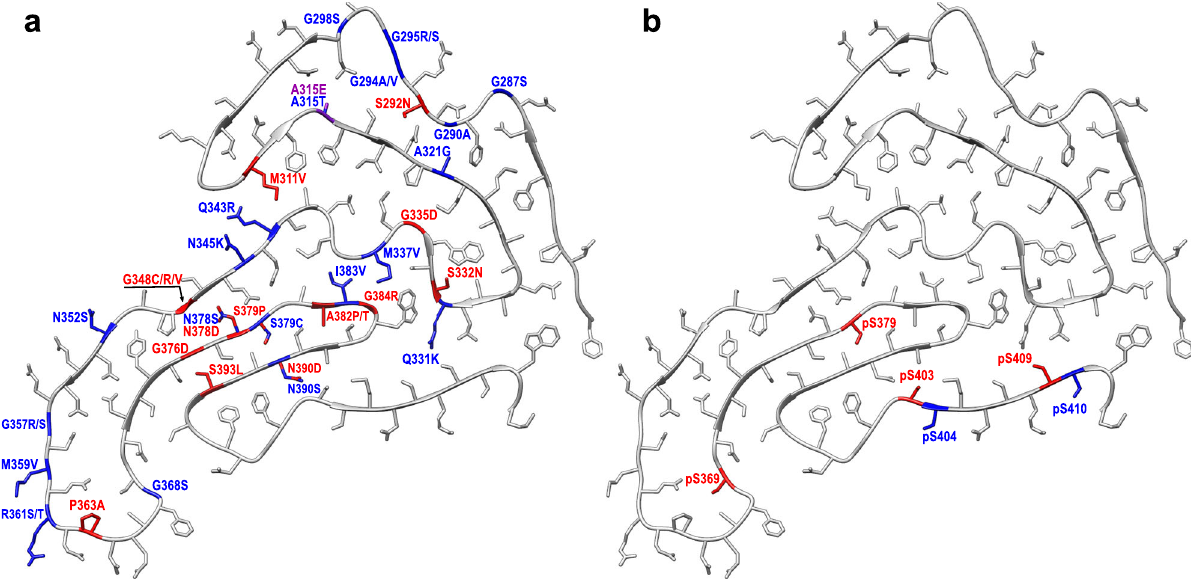
Fig. 4 Disease-related point mutations and phosphorylation sites mapped on the structure of one subunit of fi brils formed from the wild-type, non- phosphorylated TDP-43 LCD. a Mutations that are compatible with this structure are labeled in blue. The remaining mutations (labeled in red) are not compatible with the structure determined for wild-type protein fi brils due to steric clashes within tightly packed segments of the protein (S292N, M311V, S332N, G348C/V, S379P, A382P/T, S393L), introduction of charges into the dehydrated fi bril interior (N378D, N390D), or both (G335D, G348R, G376D, G384R). P363 mutation would likely interfere with the formation of a turn observed in the fi bril structure for the wild-type protein. Given that the 295 – 299 segment is relatively fl exible in the present structure, the compatibility of A315E substitution (labeled in purple) with this structure is dif fi cult to assess. b Phosphorylation sites exposed on the surface and those buried inside the structure determined for wild-type TDP-43 LCD fi brils are labeled in blue and red, respectively. Phosphorylation of exposed S410 would require only very small structural rearrangement of the backbone of C-terminal